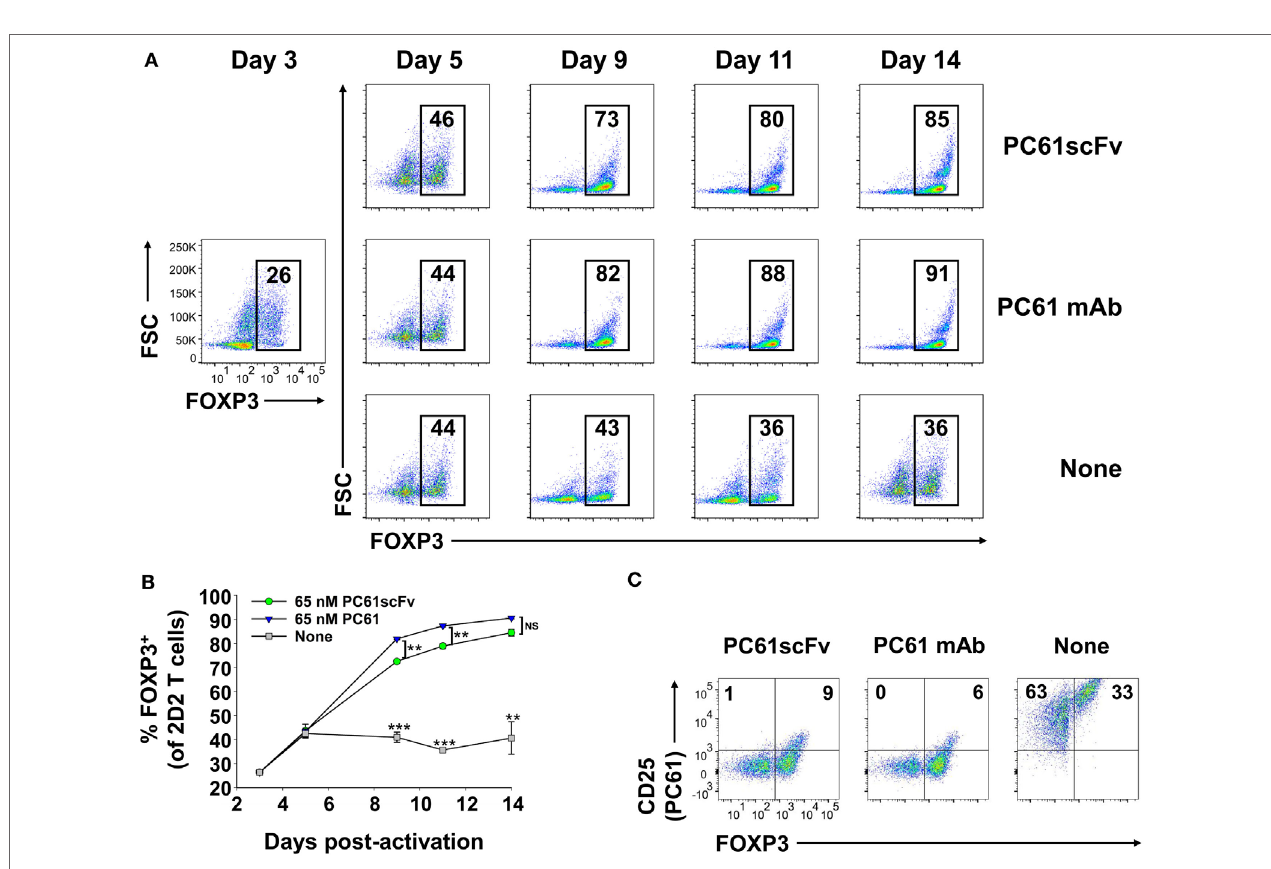
FigUre 11 | Like the intact PC61 monoclonal antibody (mAb), the monovalent PC61scFv stabilized regulatory T cell (Treg) lines. 2D2-FIG splenocytes were activated at a density of 2 × 10 6 cells/ml in cRPMI with MOG35-55 (1 µM) in the presence of TGF- β (10 nM). After 3 days of activation, T cells were cultured ( n = 2) at a density of 500,000 cells/ml in IL-2 together with 65 nM PC61scFv, 65 nM PC61 mAb, or vehicle. Cells were passaged under the same conditions every 3–4 days. (a,B) Representative dotplots and timecourse data show FOXP3 + Treg percentages in the V β 11 + T cell population (values given at the top of each